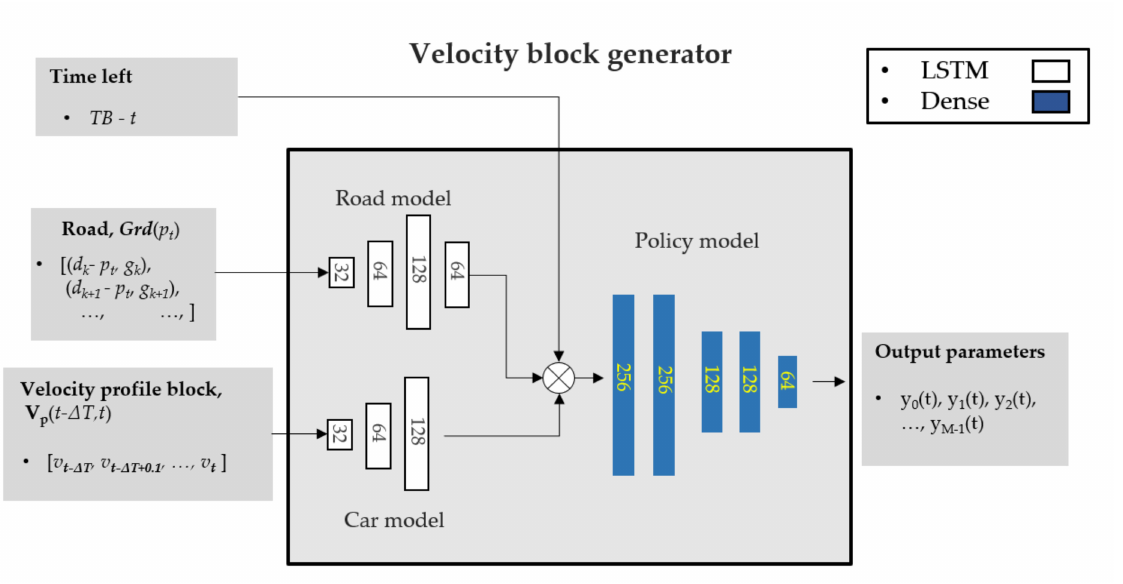
Figure 7. Deep neural network (DNN) model structure. Sequential data is passed through LSTM layers by reducing its dimensionality. LSTM layers are suitable for processing sequential data and extracting meaningful features. These feature tensors are concatenated with non-sequential inputs and processed all together through the dense layers to return the output tensors.